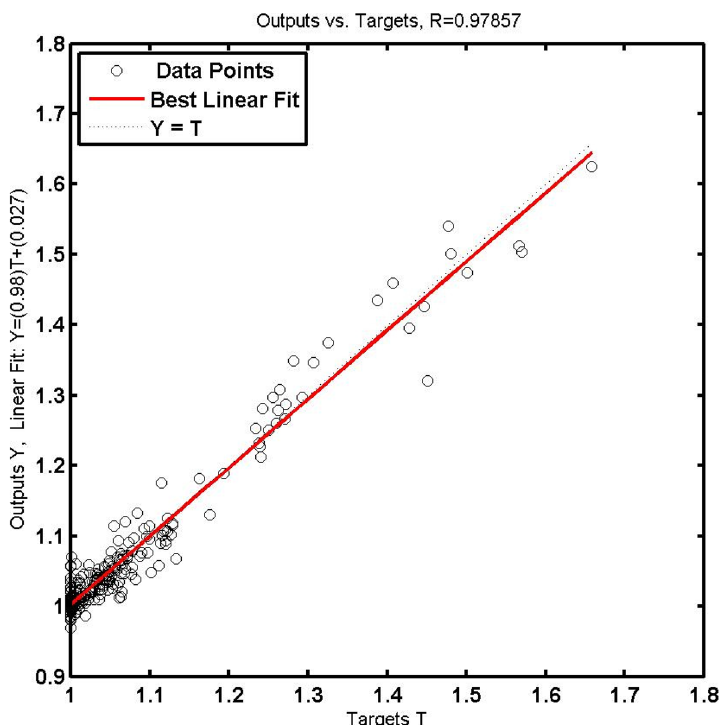
Fig. 12 Predicted (Outputs) maximum transient head just downstream the pump versus actual values (Targets) for the 1st